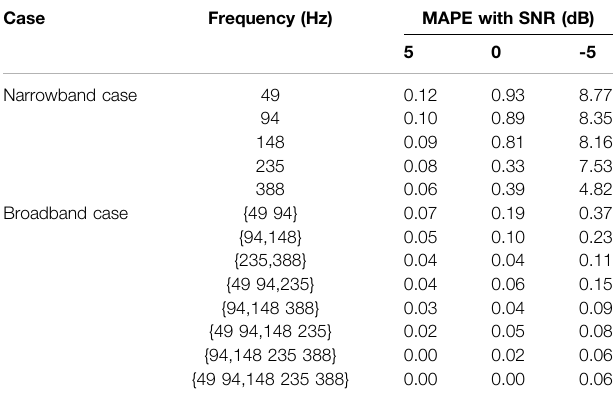
Table 3 | Depth prediction results with narrowband and broadband